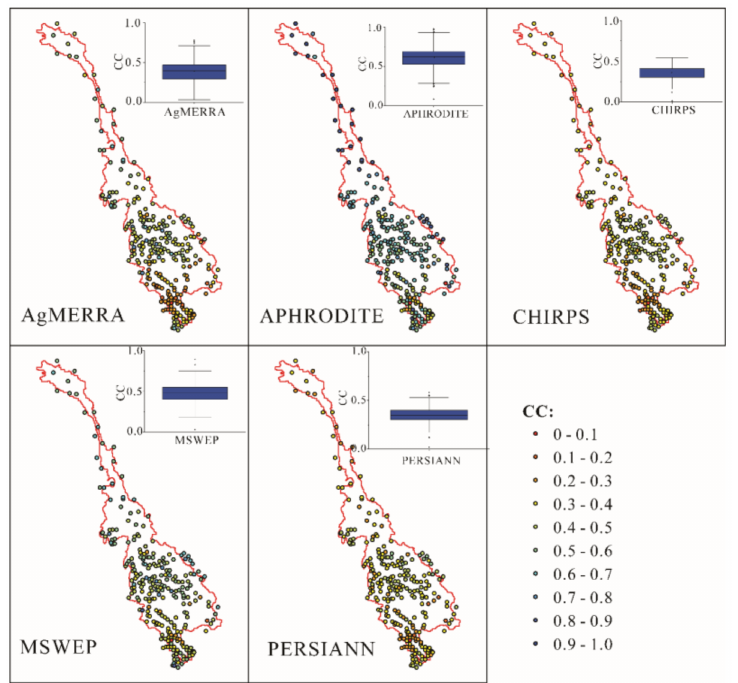
Figure 5. Correlation coefficient (CC) of five precipitation products against gauged observations at the daily scale. The boxplot of the correlation coefficients for all stations are shown in the upper right corner of the